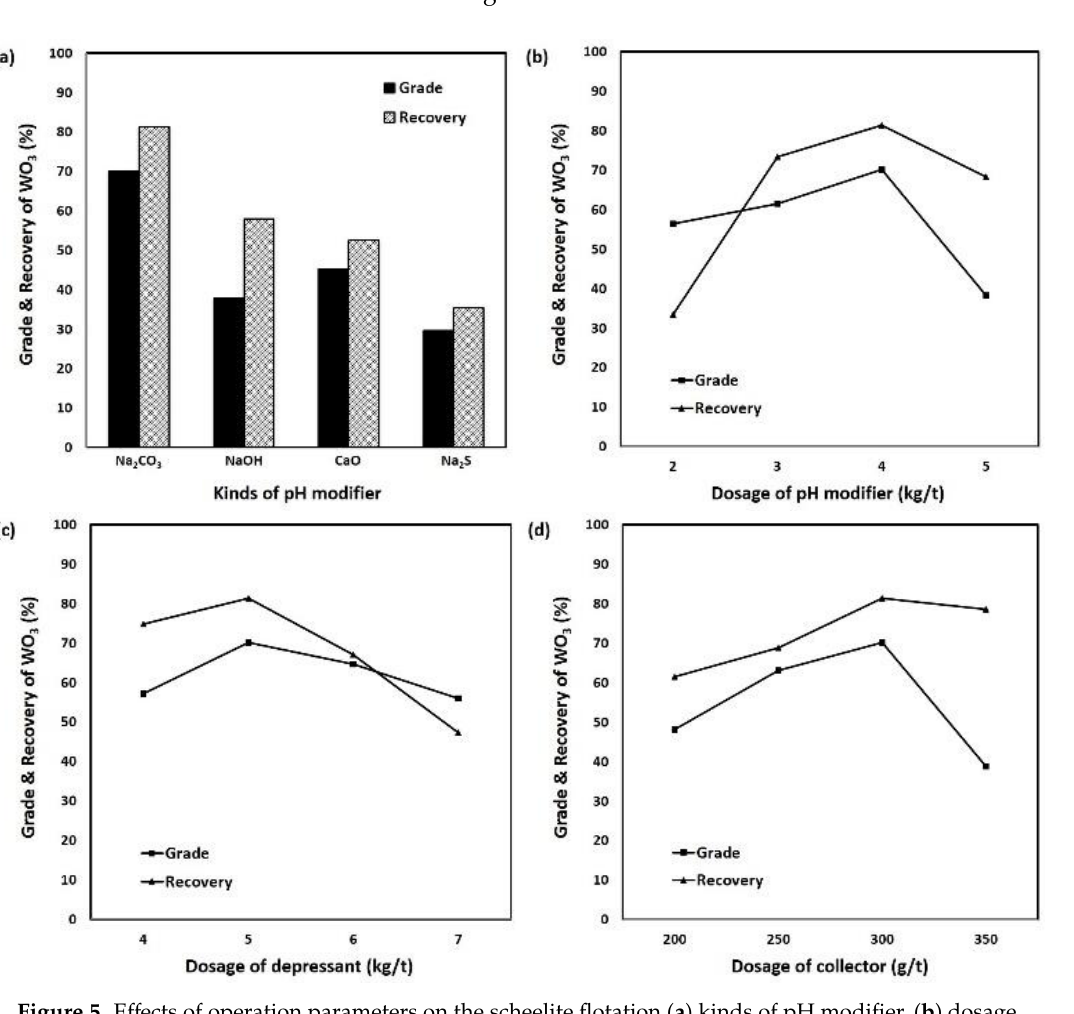
Figure 6. Schematic diagram of the selective depressing mechanism using sodium carbonate on the Ca-bearing mineral surface for recovery of scheelite . Figure 7. X-ray diffraction patterns and image of flotation products ( a ) concentrate, ( b ) sulfides, and ( c ) tailings, respectively .